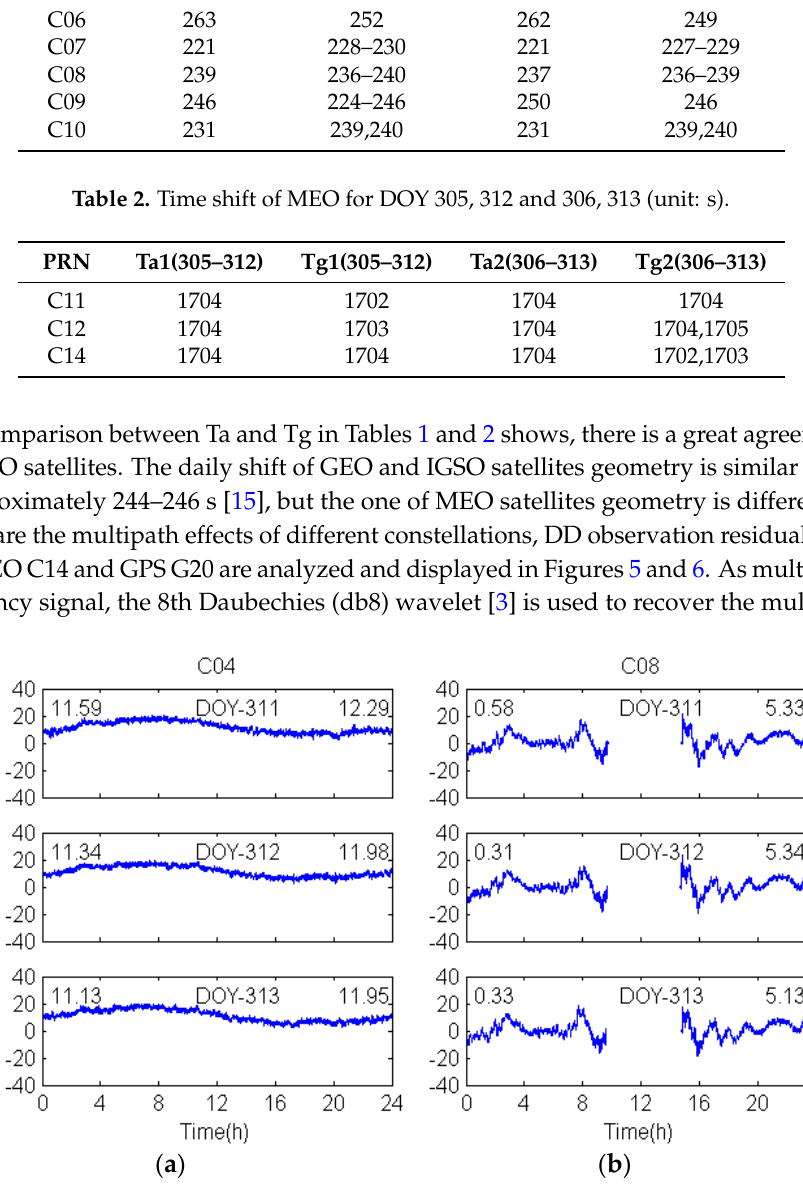
Table 3. Double difference residuals for C04, C08 and C14. DOY